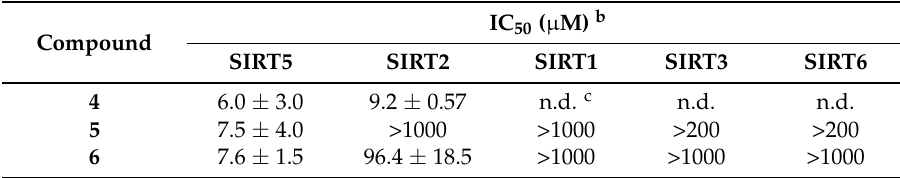
Table 2. Sirtuin inhibition by compounds 4 – 6 a .